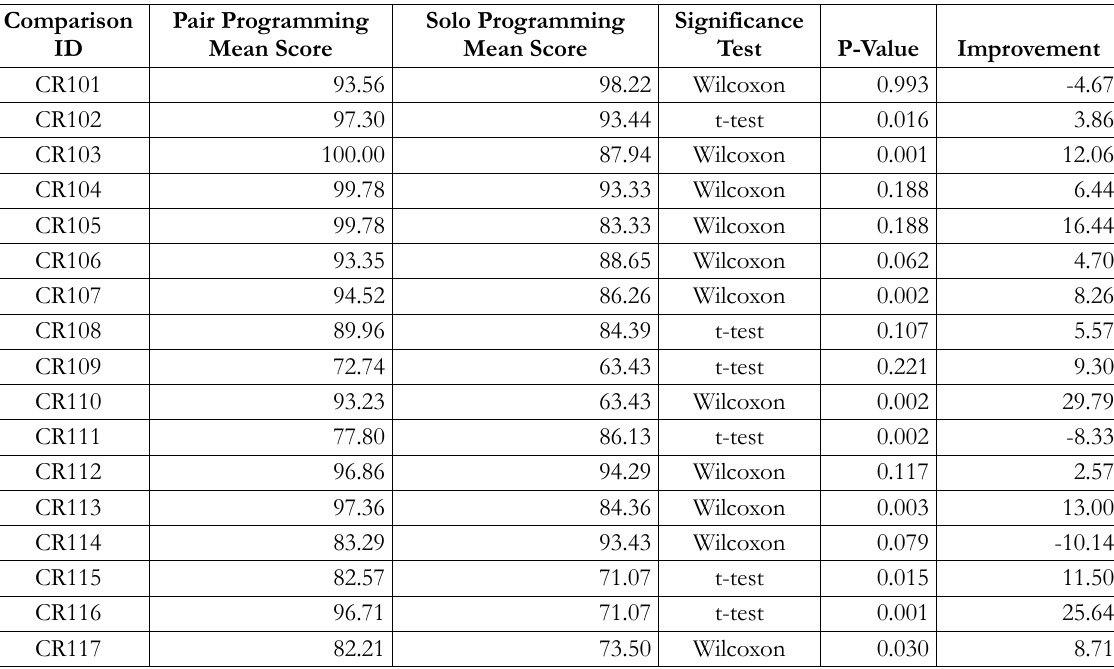
Table 8. The Improvements Gained by Utilising Pair Programming in General